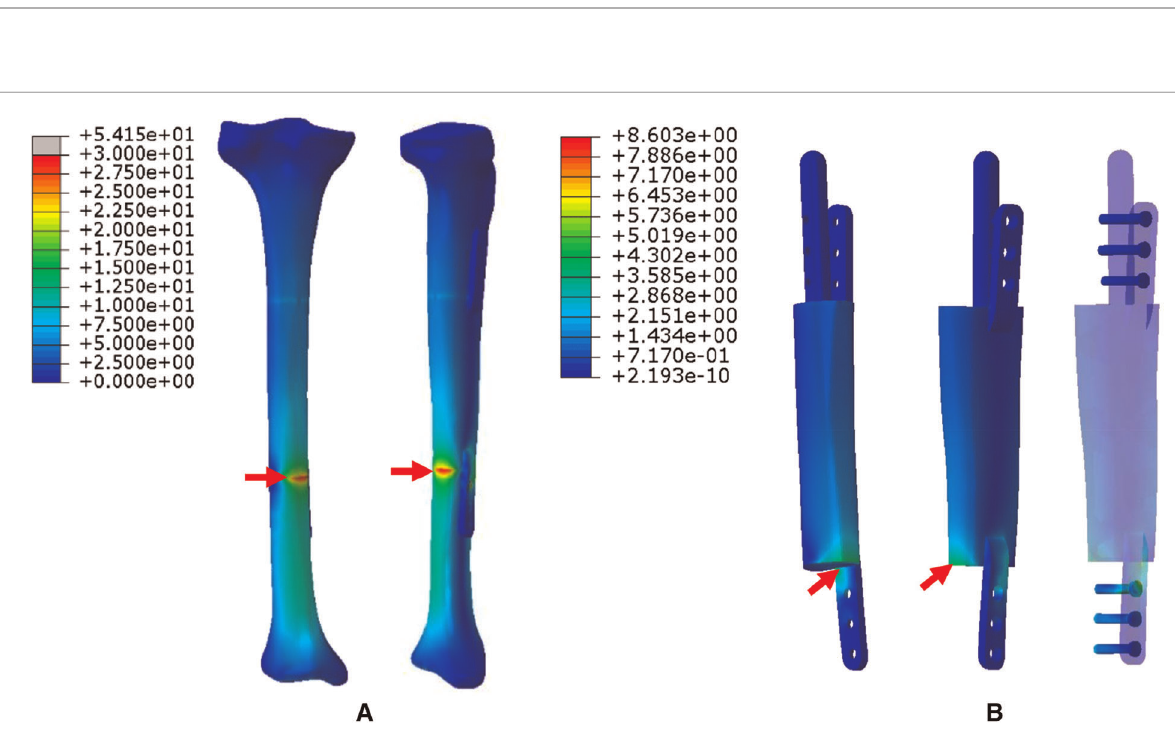
FIGURE 5 Von Mises stress distribution in Mode I, the red arrows indicate the maximum stress concentration. ( A ) Stress distribution of the integral structure. ( B ) Stress distribution of the prosthesis and internal fi xation.